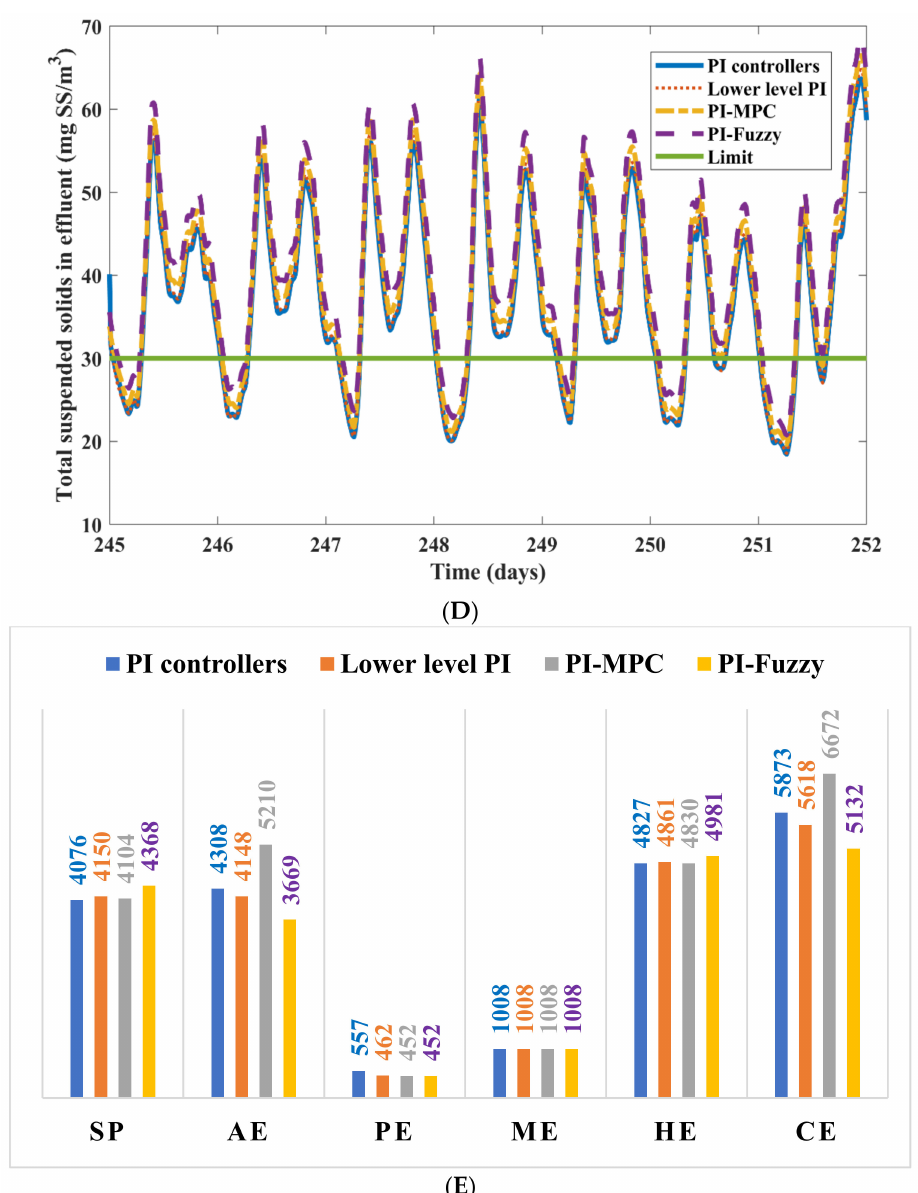
Figure 6. The effluent concentrations of ( A ) ammonia, ( B ) TN, ( C ) TP, ( D ) TSS, and ( E ) bar graph for all (SP, AE, PE, ME, HE, and consumed energy (CE)) the operational plant performance parameters are compared for four control frameworks with their corresponding average